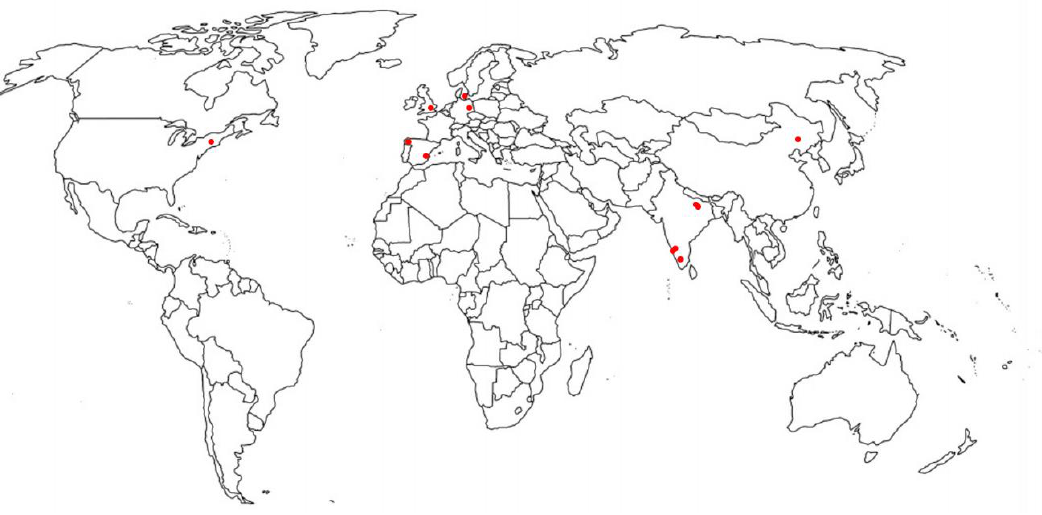
Figure 1. Geographic location of paraben detection in WWTPs.